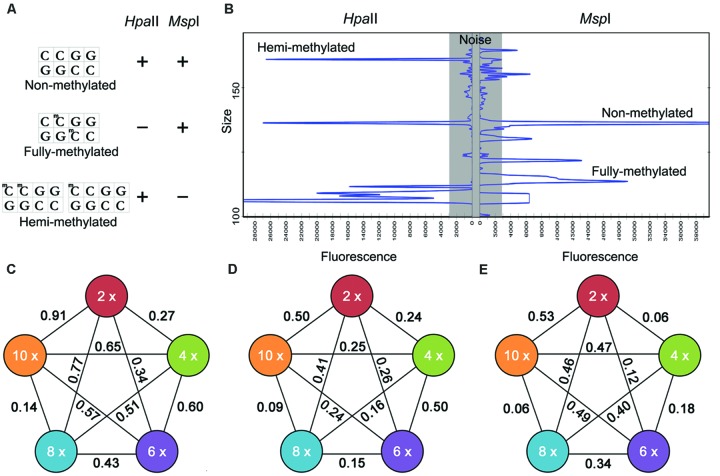
Representative fragments in methylation sensitive amplification polymorphism (MSAP) profiles (A,B) and the relationship between U-values and ploidy level (C–E). (A)
Hpa II and Msp I sensitivities to 5-CCGG methylation status (“+”: enzyme cuts; “-”: enzyme does not cut): three types of fragment generated. Type I: non-methylated, appearing in both the H and M lanes; Type II: fully methylated, present in the M but not the H lanes; Type III: hemi-methylated, present in the H but not the M lanes; (B) Examples of MSAP electrophoresis patterns in ABI3730xl; The relationship between U-values and ploidy level (C-E). U-values associated with (C) total methylation, (D) full methylation, (E) hemi-methylation. A higher U-value implies a larger difference between different samples, but only U-values>1.96 were statistically significant.